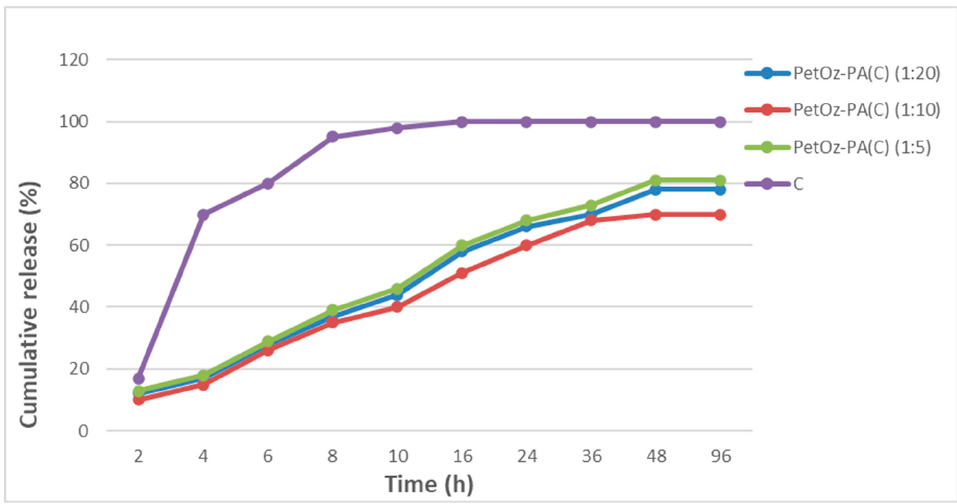
Figure 3. In vitro release profiles of C, PetOz-PA(C) (1:20), PetOz-PA(C) (1:10), and PetOz-PA(C) (1:5) ( n = 3).